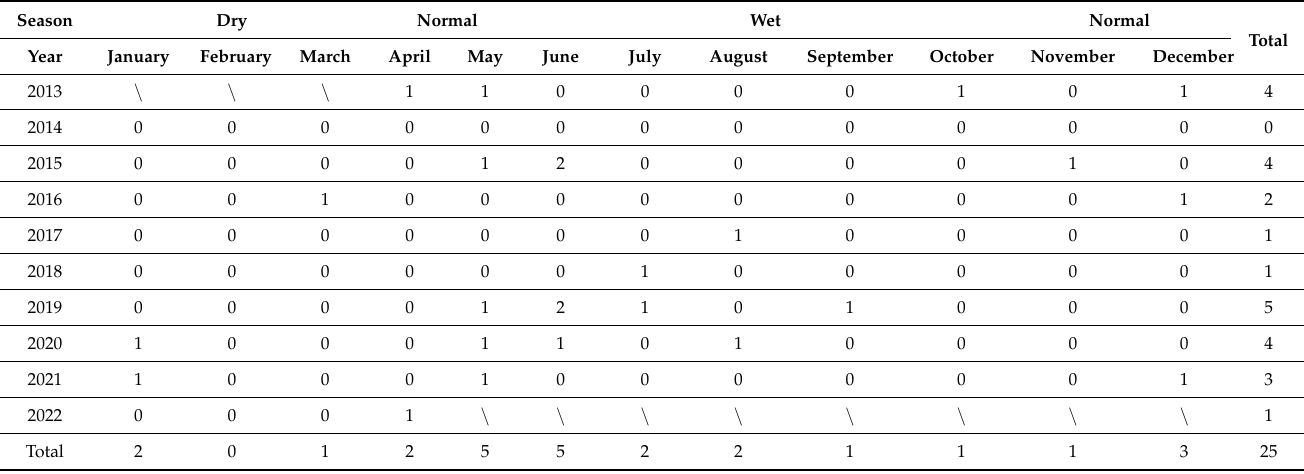
Table 1. Temporal distribution of Landsat 8 images used in this